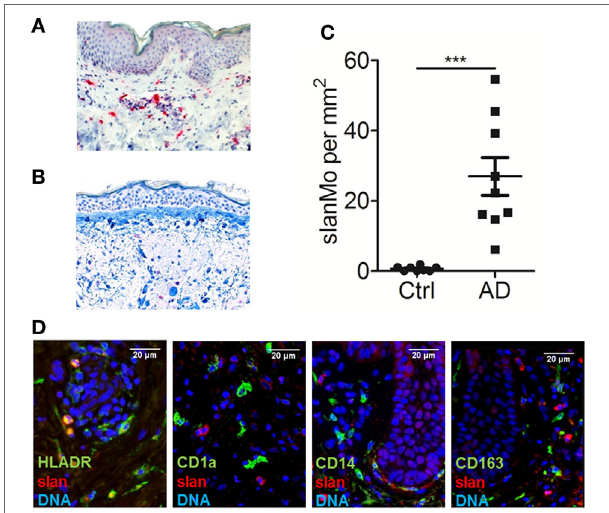
FigUre 1 | slan + cells are a distinct population of dermal monocytes in atopic dermatitis. Immunohistochemical staining of 6-sulfo LacNAc- expressing monocytes (slanMo) in normal human skin (a) and skin samples from an atopic dermatitis patient (B) . The results of multiple samples are shown in (c) : healthy skin n = 10 and skin from atopic dermatitis patients n = 9. (D) Immunofluorescent stainings of slan (red) in combination with either HLA-DR, CD1a, CD14, or CD163 (green) was performed. Cell nuclei were stained with DAPI (blue). (a,B,D) Representative results of 10 donors that were analyzed. Statistical significance (c) was calculated using an unpaired t